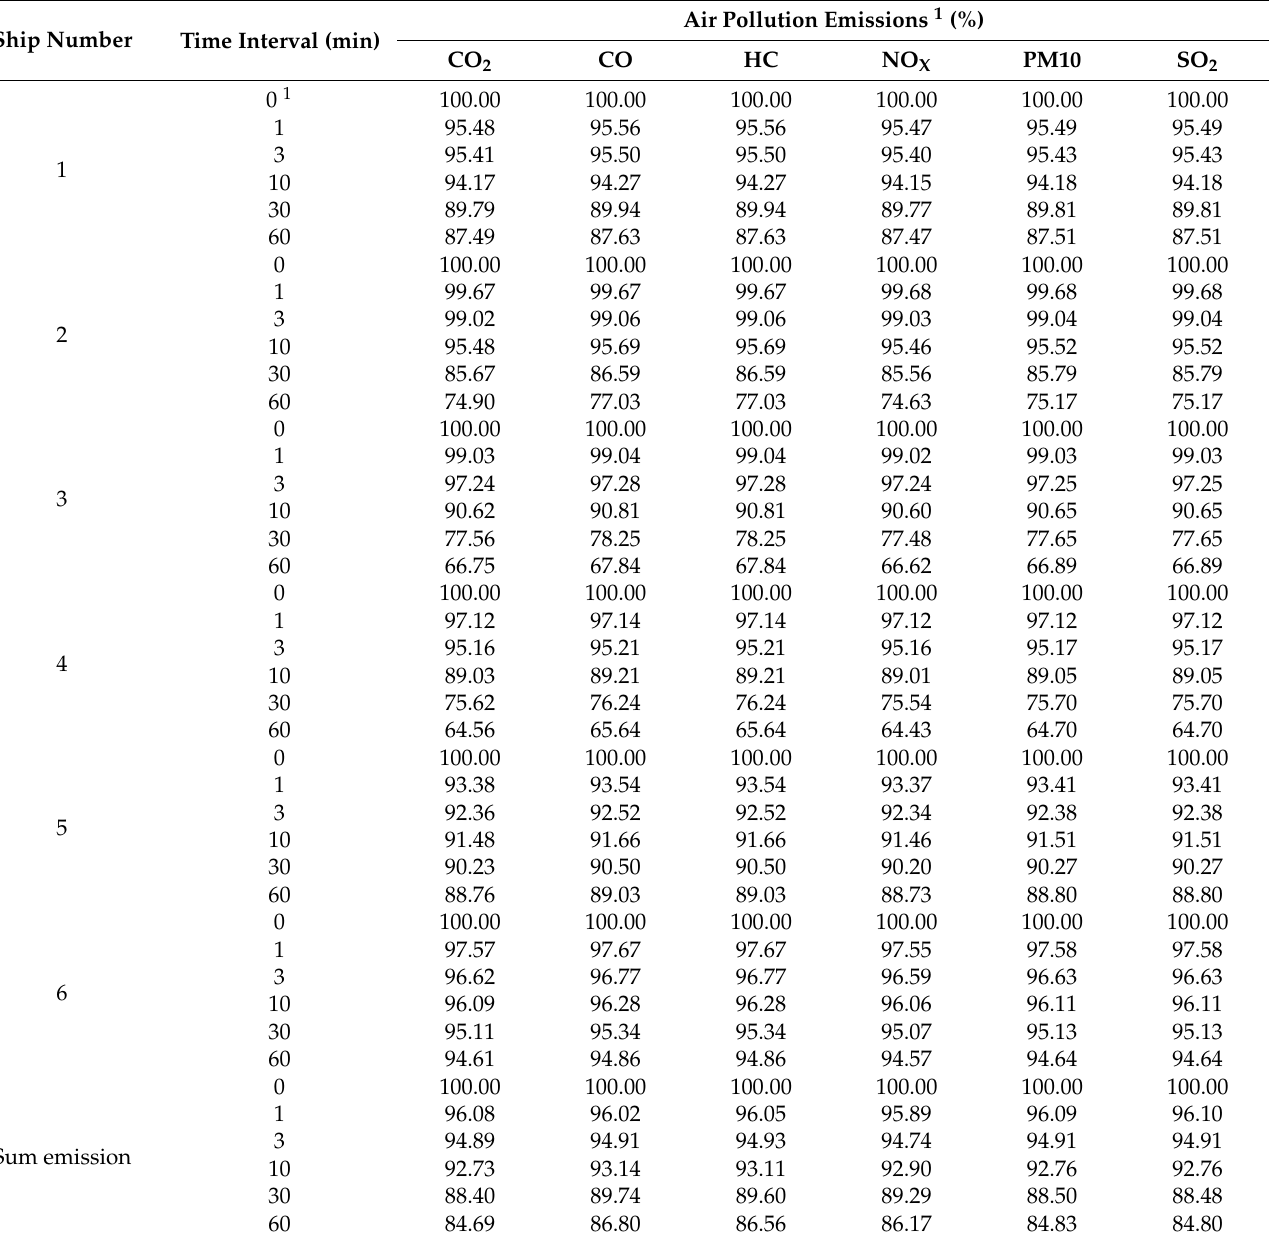
Table 3. Effect of thinning the AIS data on ship emissions inventories for one year at different time